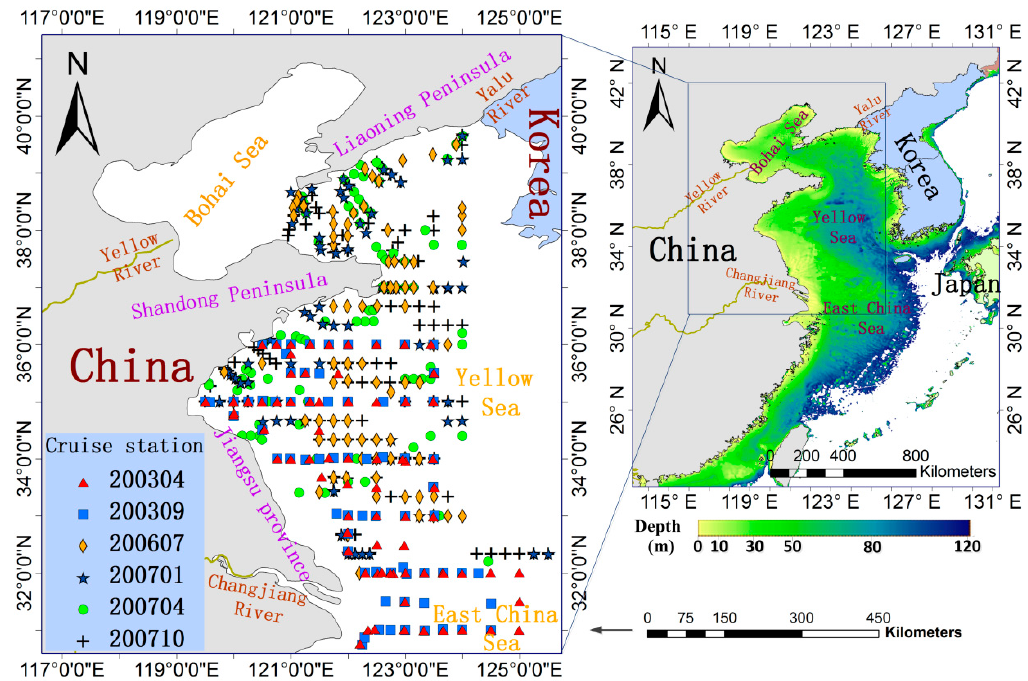
Figure 1. Locations of the in-situ sampling sites in the Yellow Sea ( left ); and coastal water depths from 0 to 120 m, which were referenced from the GEBCO_2014 Grid, www.gebco.net ( right ).